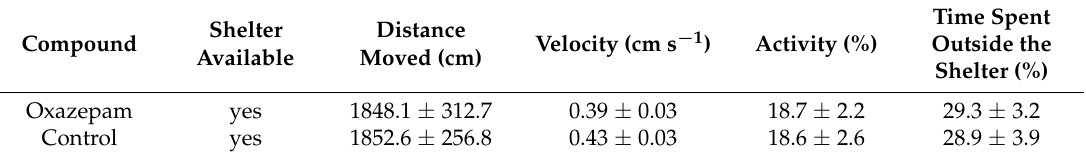
Table 5. The values of the distance moved, velocity, activity, and time spent outside the shelter in crayfish exposed to oxazepam and in control crayfish, in set-ups with and without available shelter. Data are shown as mean ± standard deviation.